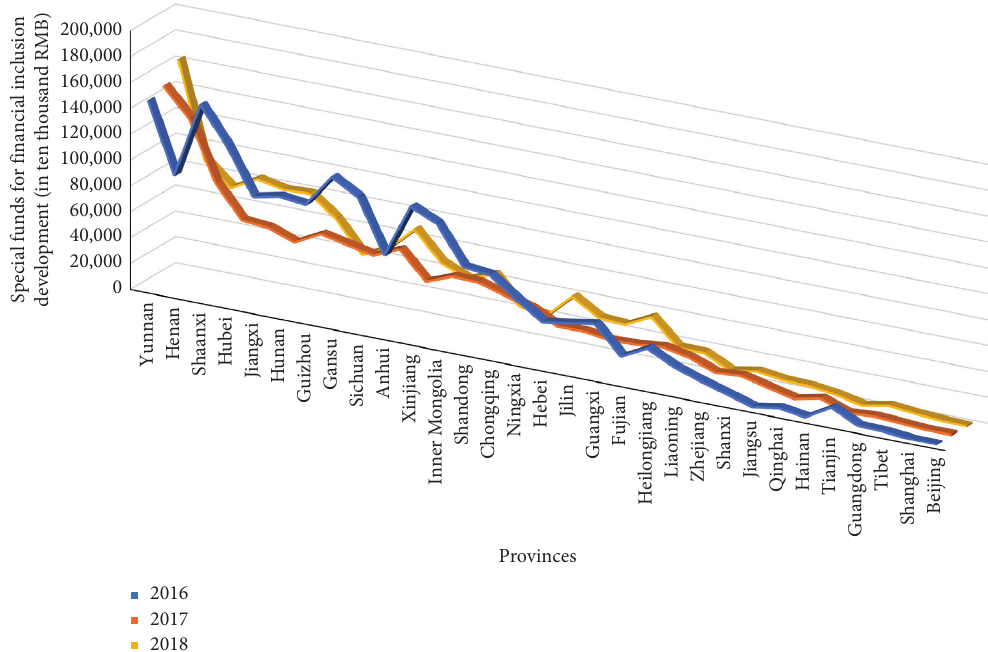
Figure 2: The allocation of special funds for financial inclusion development in various provinces in China from 2016 to 2018.